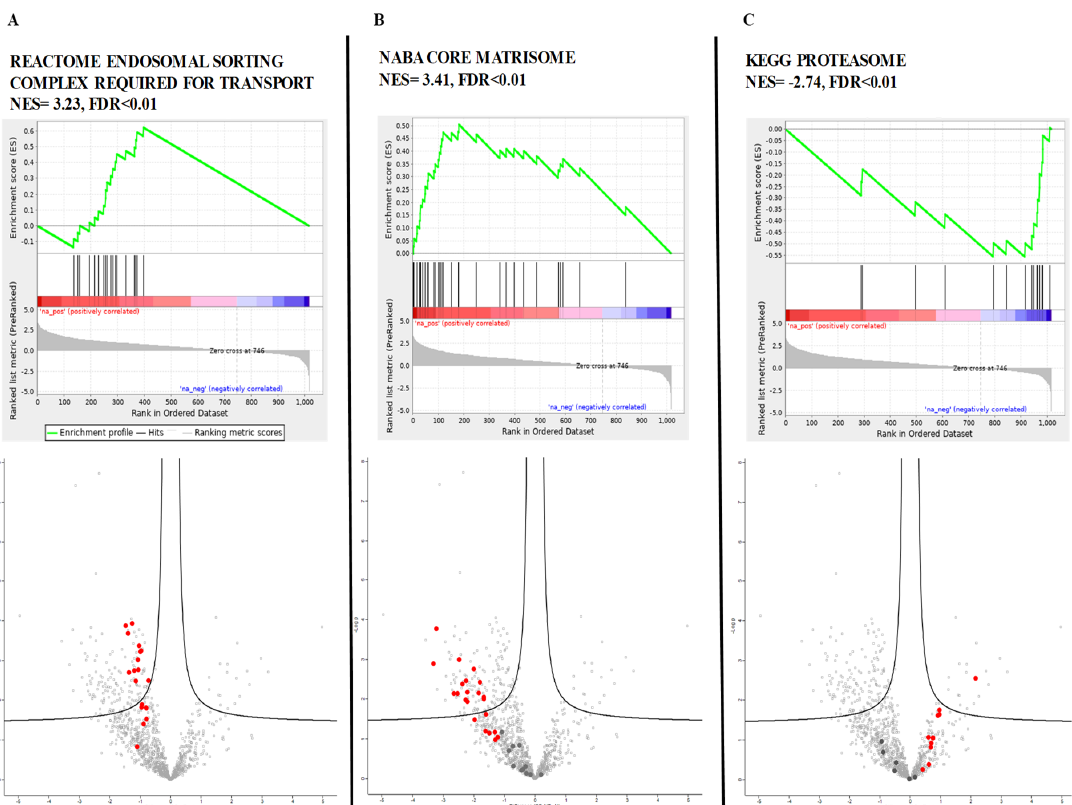
Figure 3. Gene set enrichment analysis (GSEA) enrichment and volcano plots of significantly dysregulated pathways. GSEA enrichment plot and visualization of the corresponding gene set on volcano plot are displayed for ( A ) endosomal sorting complex required for transport (ESCRT), ( B ) matrisome, and ( C ) proteasome pathways. The enrichment score (ES, green line) and the normalized enrichment score (NES) reflect the degree to which the gene set is over-represented at the top or bottom of the ranked list of genes included in the analysis. Black bars illustrate the position of genes belonging to the gene set in the ranked list of genes. In the volcano plot of proteomic data, the Log2 of the RP ( p value) statistic is plotted against Log2 of fold change. Bold points in the volcano plot correspond to the proteins resulting from the genes belonging to the gene set. The proteins corresponding to the leading genes are depicted in red while the other genes are depicted in dark gray. Proteins outside the vertical dotted lines have more than 2-fold differential expression.